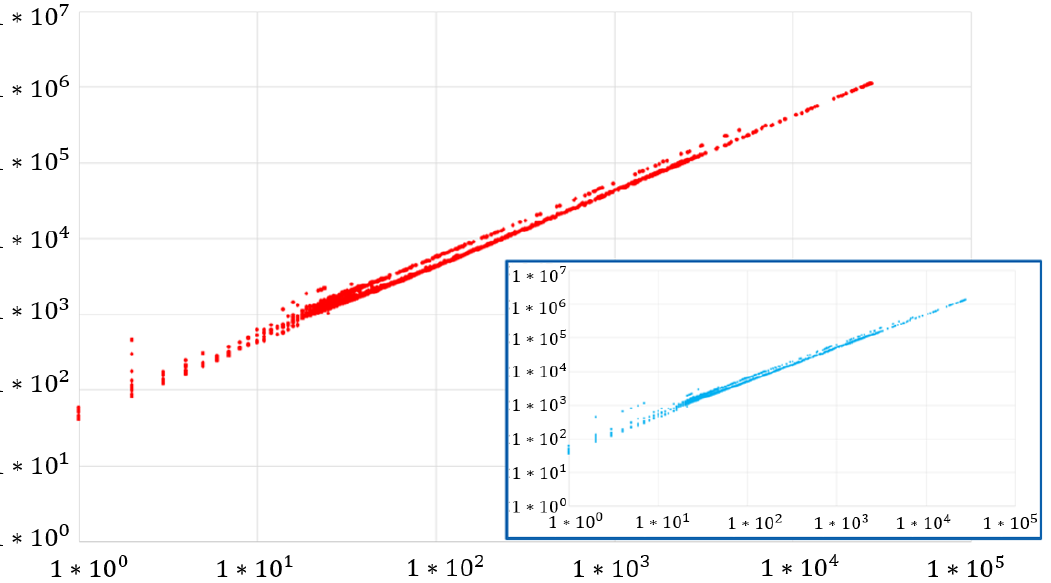
Figure 7. Downlink (red) and uplink (blue) traffic flow distribution of APN “A1” (x axis: number of packets, y axis: Size of flows [Byte]).